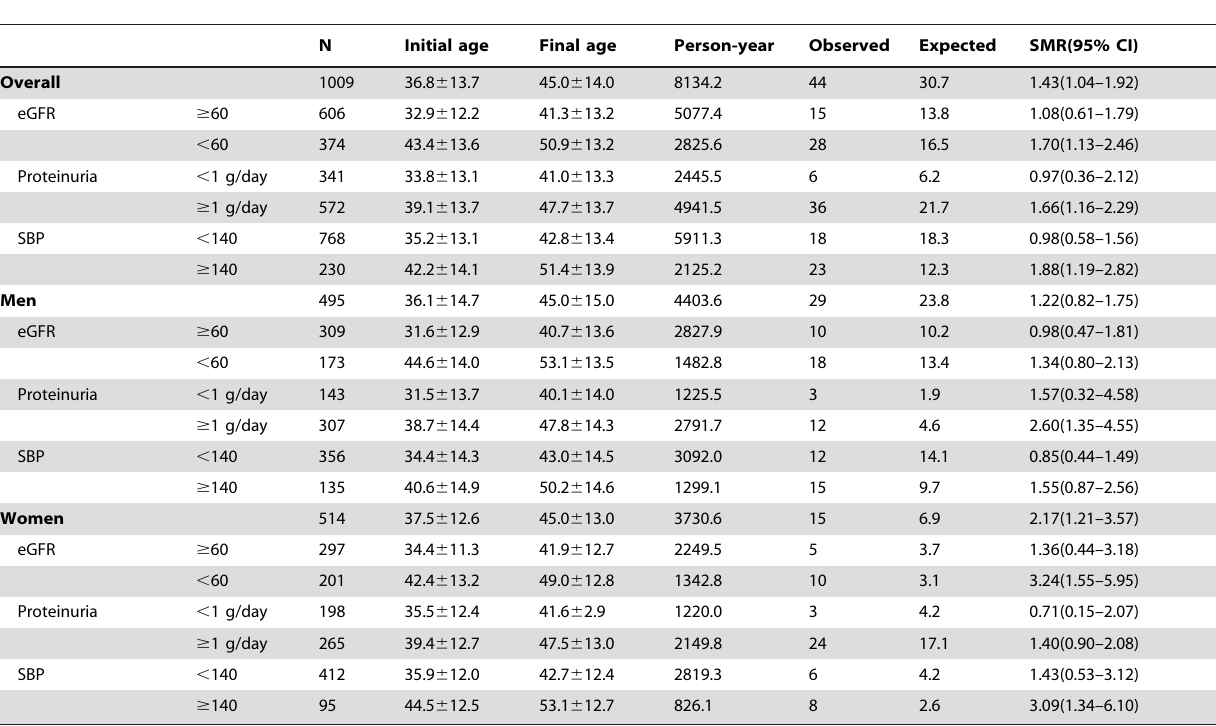
Table 6. Standardized mortality ratios (SMRs) in overall and subpopulation of IgAN